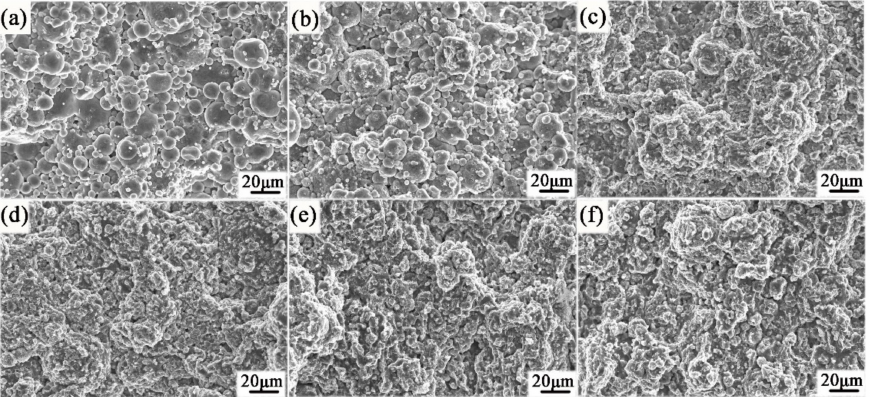
Figure 11. SEM/SE micrograph of fracture surface with different sintering temperature ( a ) 560 ◦ C